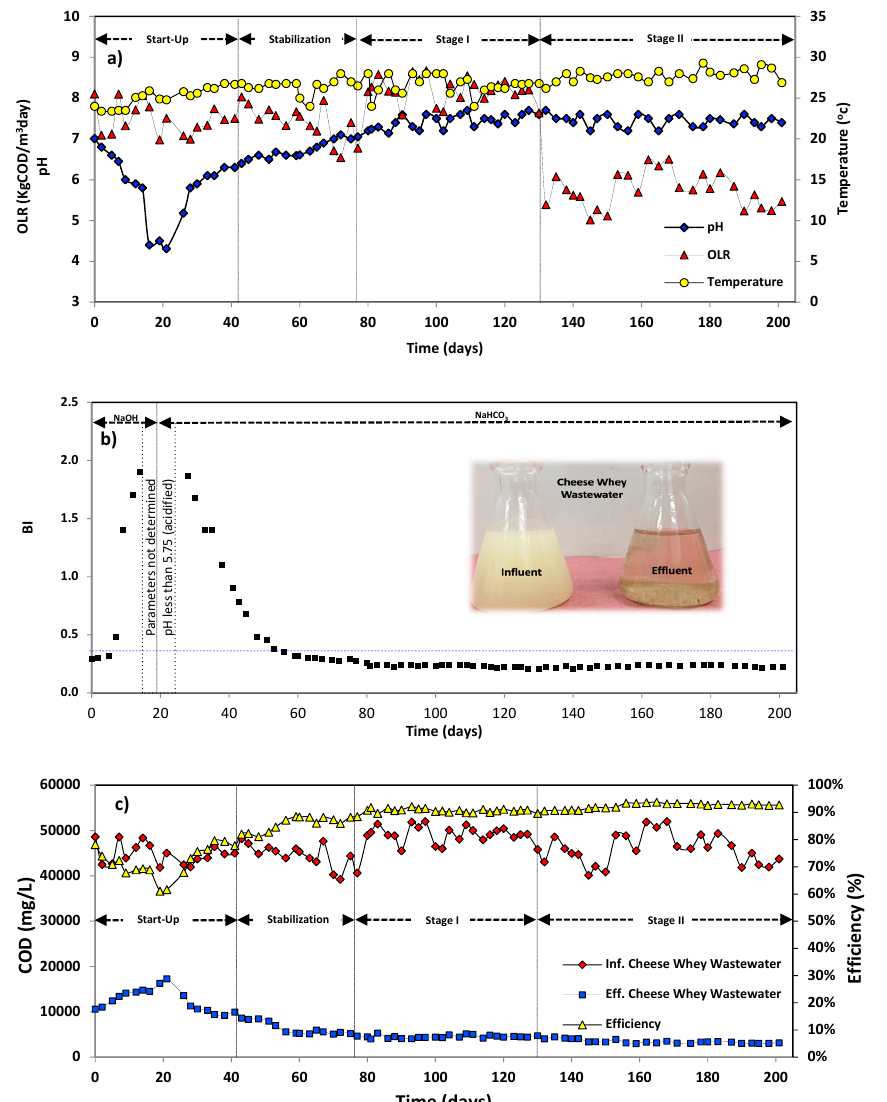
Figure 6. Evolution of the performance EGSB bioreactor under continuous CWW supply. ( a ) OLR, pH and temperature, ( b ) Buffer index (BI) monitoring and ( c ) The variations on COD concentration and removal efficiency.